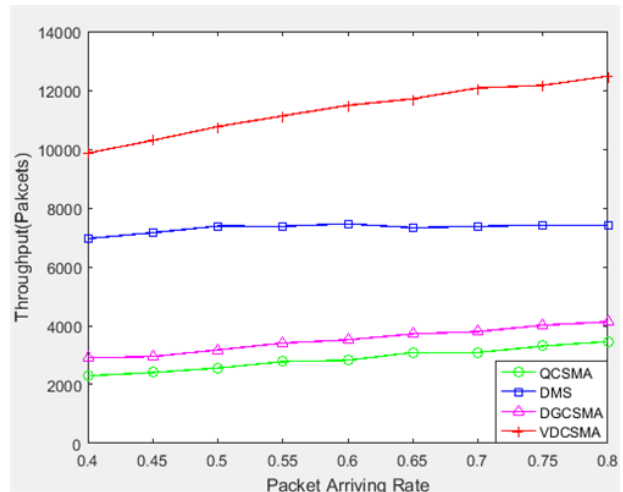
Figure 10. Throughput of real-time links: λ ∈ [ 0.4,0.8 ] .